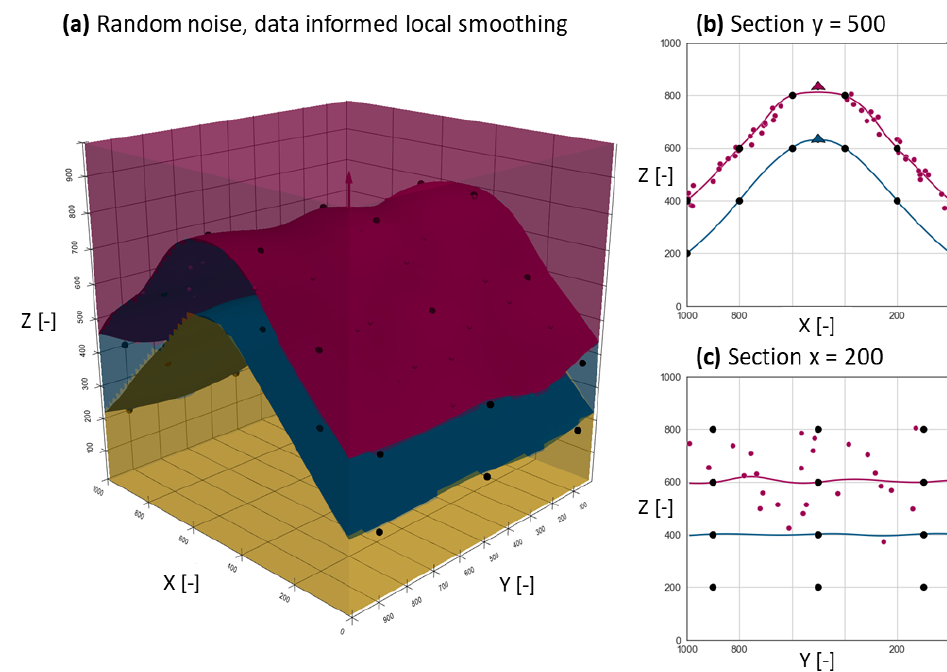
Figure 7. Geomodel of a folded unit. Fifty noisy data points were added to the data of model in Figure 5. Original surface data points feature local smoothing of zero, added noisy data points have a local smoothing of 0.54 (standard deviation of 25 scaled to scalar field). ( a ) 3D model view. ( b ) Section viewing at y = 500. ( c ) Section at x = 200. Note that input data are projected on section planes.